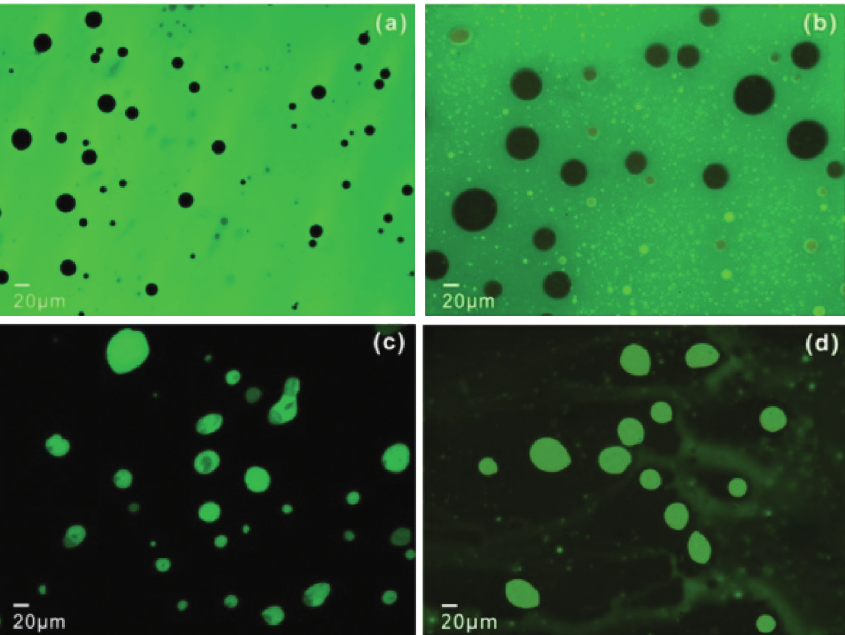
Figure 10: FM images of (a) CEA-0.4 blend, (b) cured CEA-0.4, (c) CEA-1.5 blend, and (d) cured CEA-1.5 [56]. Note: CEA � cold-mixed epoxy asphalt; 0.4, 1.5 � ratio of epoxy resin to asphalt � 1: 0.4 and 1 :1.5,